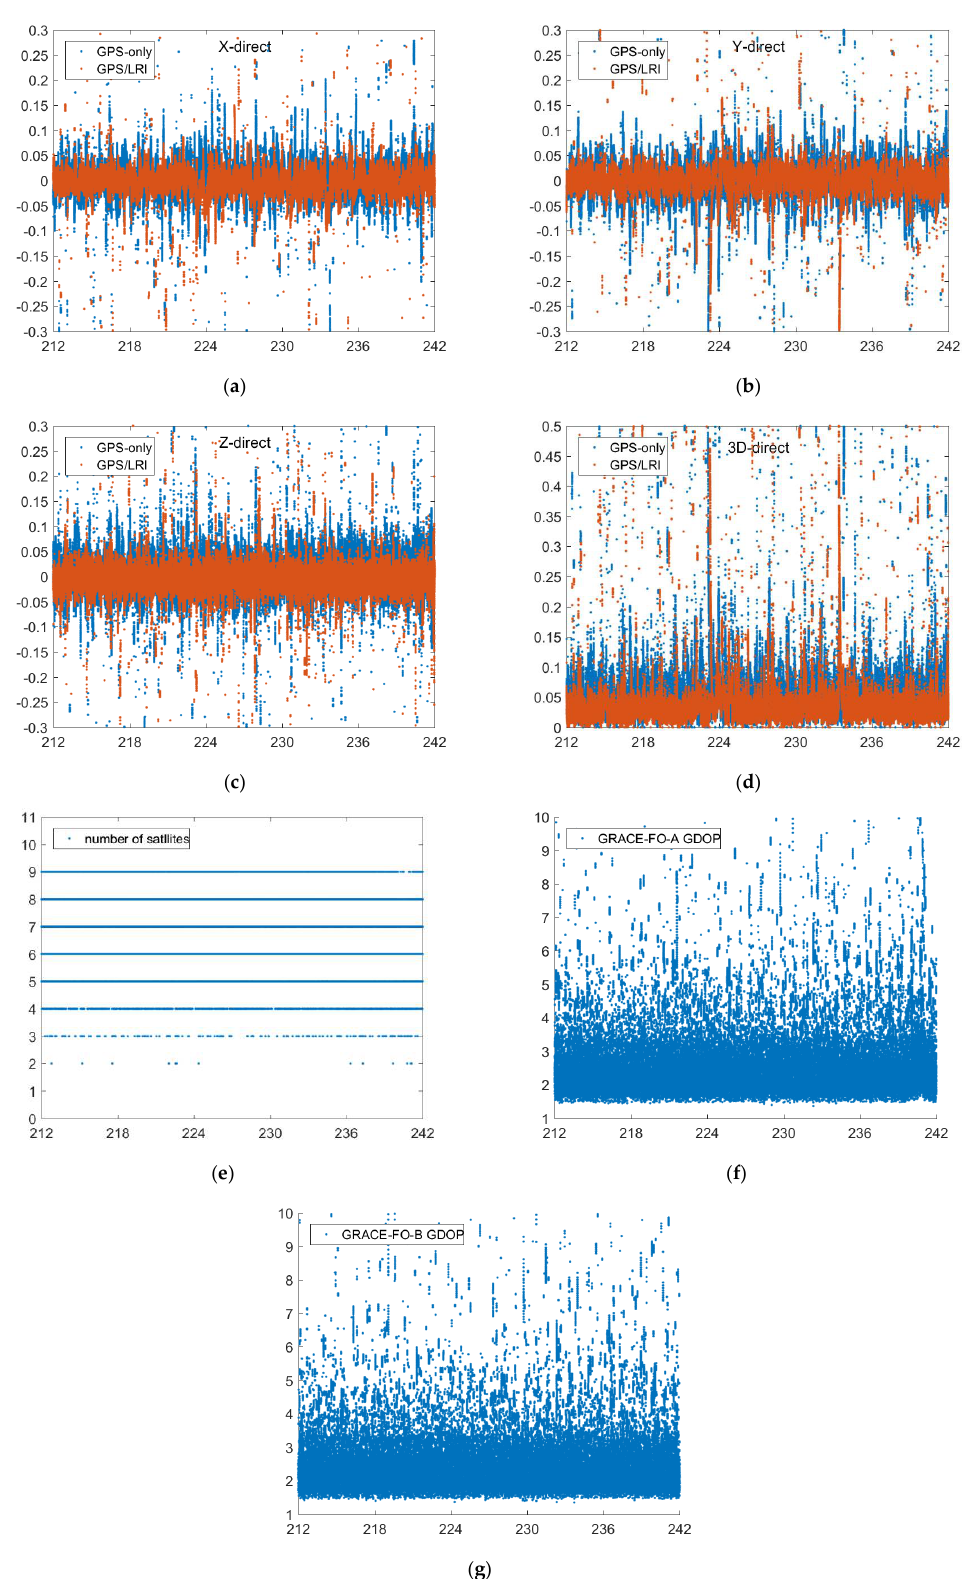
Figure 5. Reference orbit check for GRACE-FO in the X, Y, Z, 3D (X, Y, Z are components of the baseline vector, unit: m,( a – d )) directions (days 212–242), number of satellites for each epoch( e ) and GDOP( f , g ).